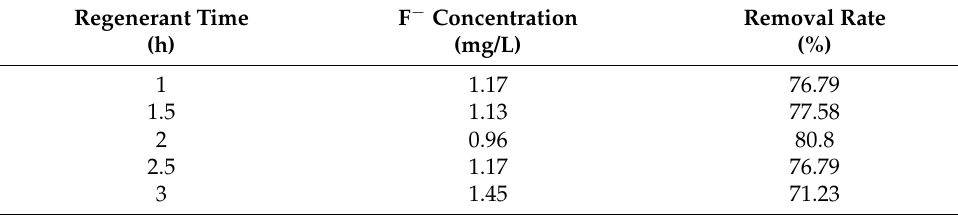
Table 6. Influence of regenerant time on regeneration effects (Na 2 CO 3 ).